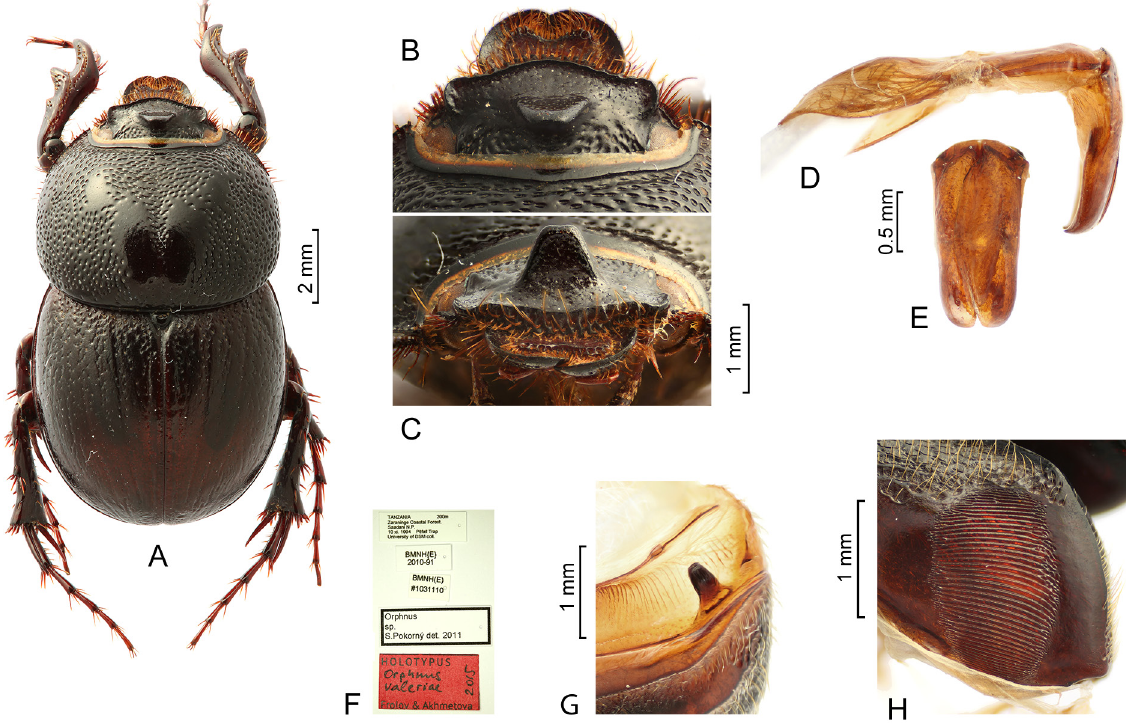
Fig. 3. Orphnus valeriae sp. nov. A . Habitus. B–C . Head in dorsal and apical view. D . Aedeagus in lateral view. E . Parameres in dorsal view. F . Labels of holotype. G . Abdomen in dorsal view. H . Stridulatory field. A–F. Holotype. G–H.